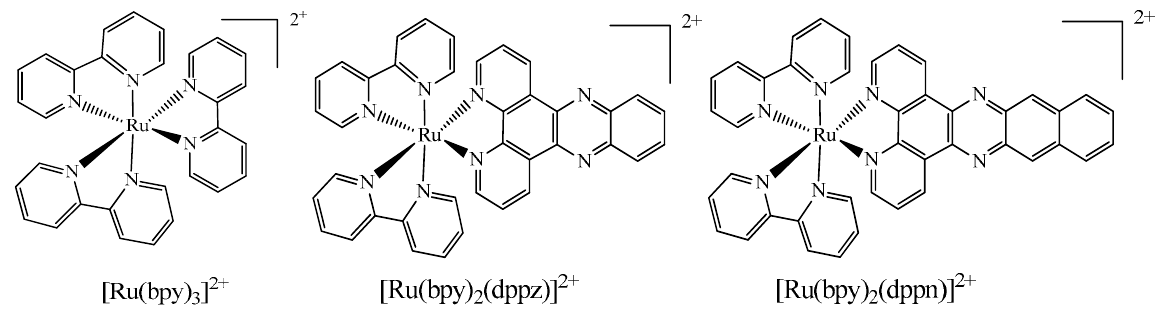
Figure 2. Chemical structure of [Ru(bpy) 3 ] 2+ (bpy = 2,2 ′ -bipyridine), [Ru(bpy) 2 (dppz)] 2+ (dppz = di- pyrido[3,2-a:2 ′ ,3 ′ c]phenazine) and [Ru(bpy) 2 (dppn)] 2+ (dppn = benzo[i]dipyrido[3,2-a:2’,3’-c]phena- zine). Adapted from [48] with permission from the journal Chem. Sci ., Copyright 2015.